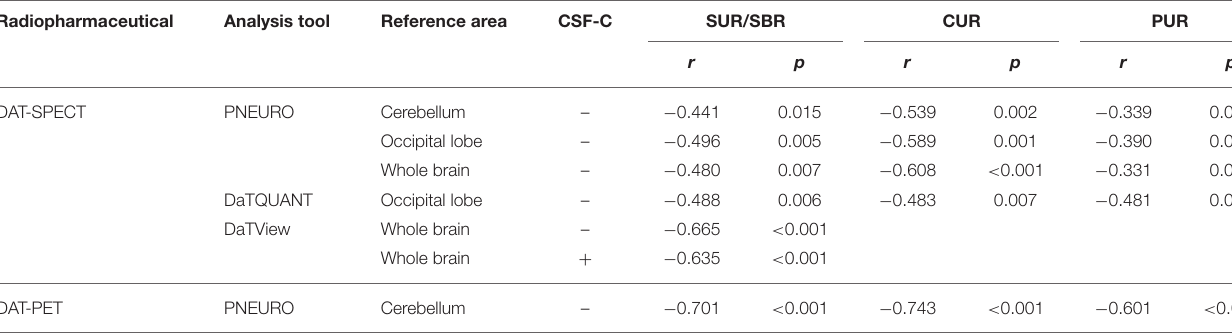
Table 2A | Age correlation with DAT activity, measured with DAT-SPECT and DAT-PET. Radiopharmaceutical Analysis